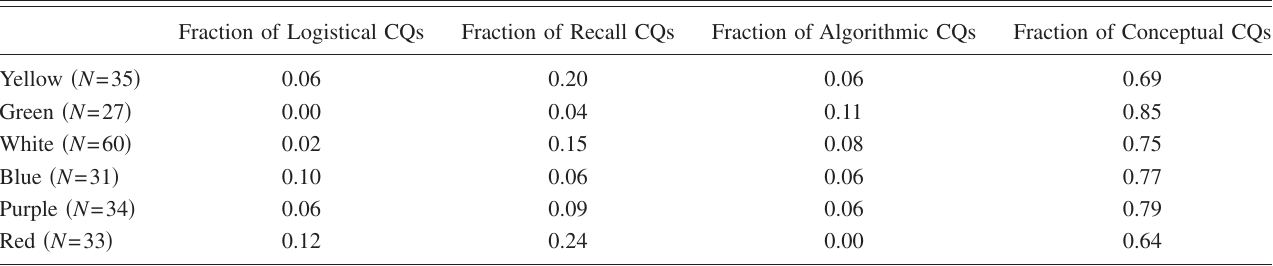
TABLE IV. Fraction of Clicker Questions that were: Logistical, Recall, Algorithmic, or Conceptual Fraction of Logistical CQs Fraction of Recall CQs Fraction of Algorithmic CQs